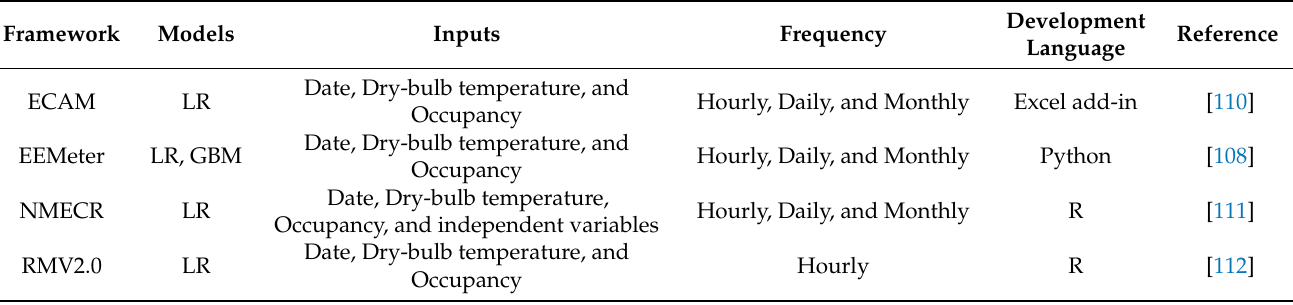
Table 9. Sample of existing M&V